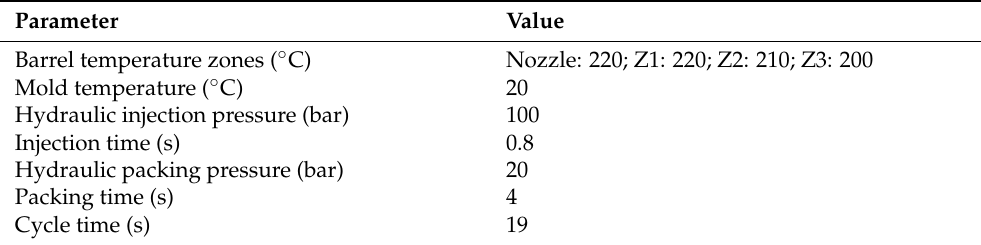
Table 2. List of the main process parameters used during the test runs.